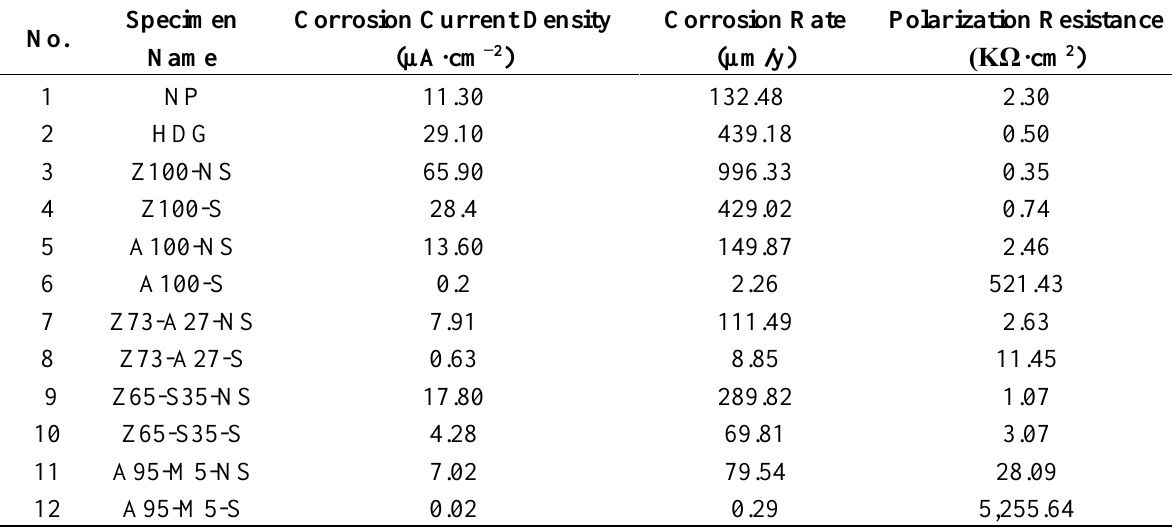
Table 5. Values of corrosion current density, corrosion rate and polarization resistance of each type of